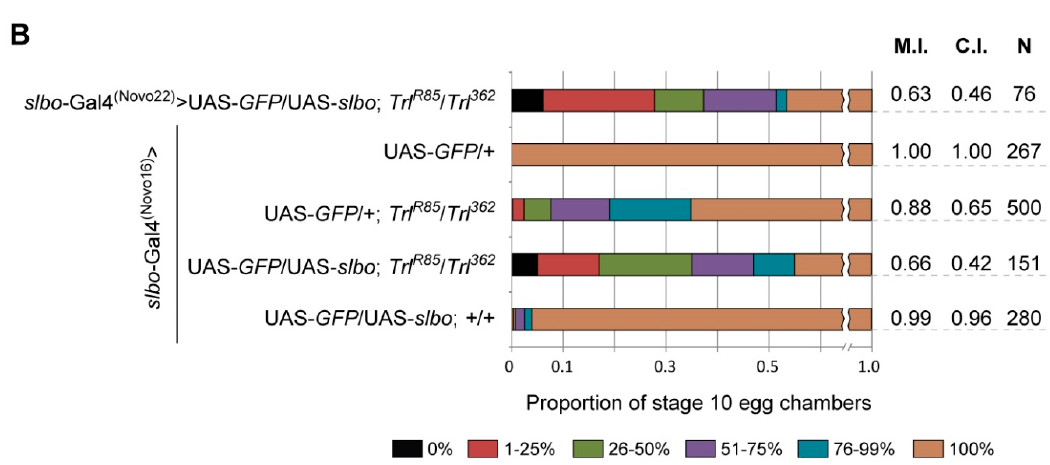
Figure 4. Overexpression of Slbo does not rescue impaired BC migration in Trl mutants. ( A ) Comparison of the slbo and Trl mRNA levels (determined by RT-qPCR) in ovaries of the indicated genotypes. The data for the Oregon-R control are the same as in Figure 2E. Error bars represent standard error of the mean. ( B ) Quantification of the BC migration phenotypes in stage 10 egg chambers of the indicated genotypes. The combination of the slbo -Gal4 (Novo16) or slbo -Gal4 (Novo22) driver [30] with the UAS- GFP reporter construct was used to mark BCs. For quantitation, the nurse cell region of egg chambers was divided into 6 groups according to the percentage of the total distance travelled by BCs: 0% (black), 1–25% (dark red), 26–50% (light green), 51–75% (violet), 76–99% (blue) and 100% (brown) [30]. M.I., C.I. and N denote the migration index, the completion index and the number of egg chambers examined, respectively.